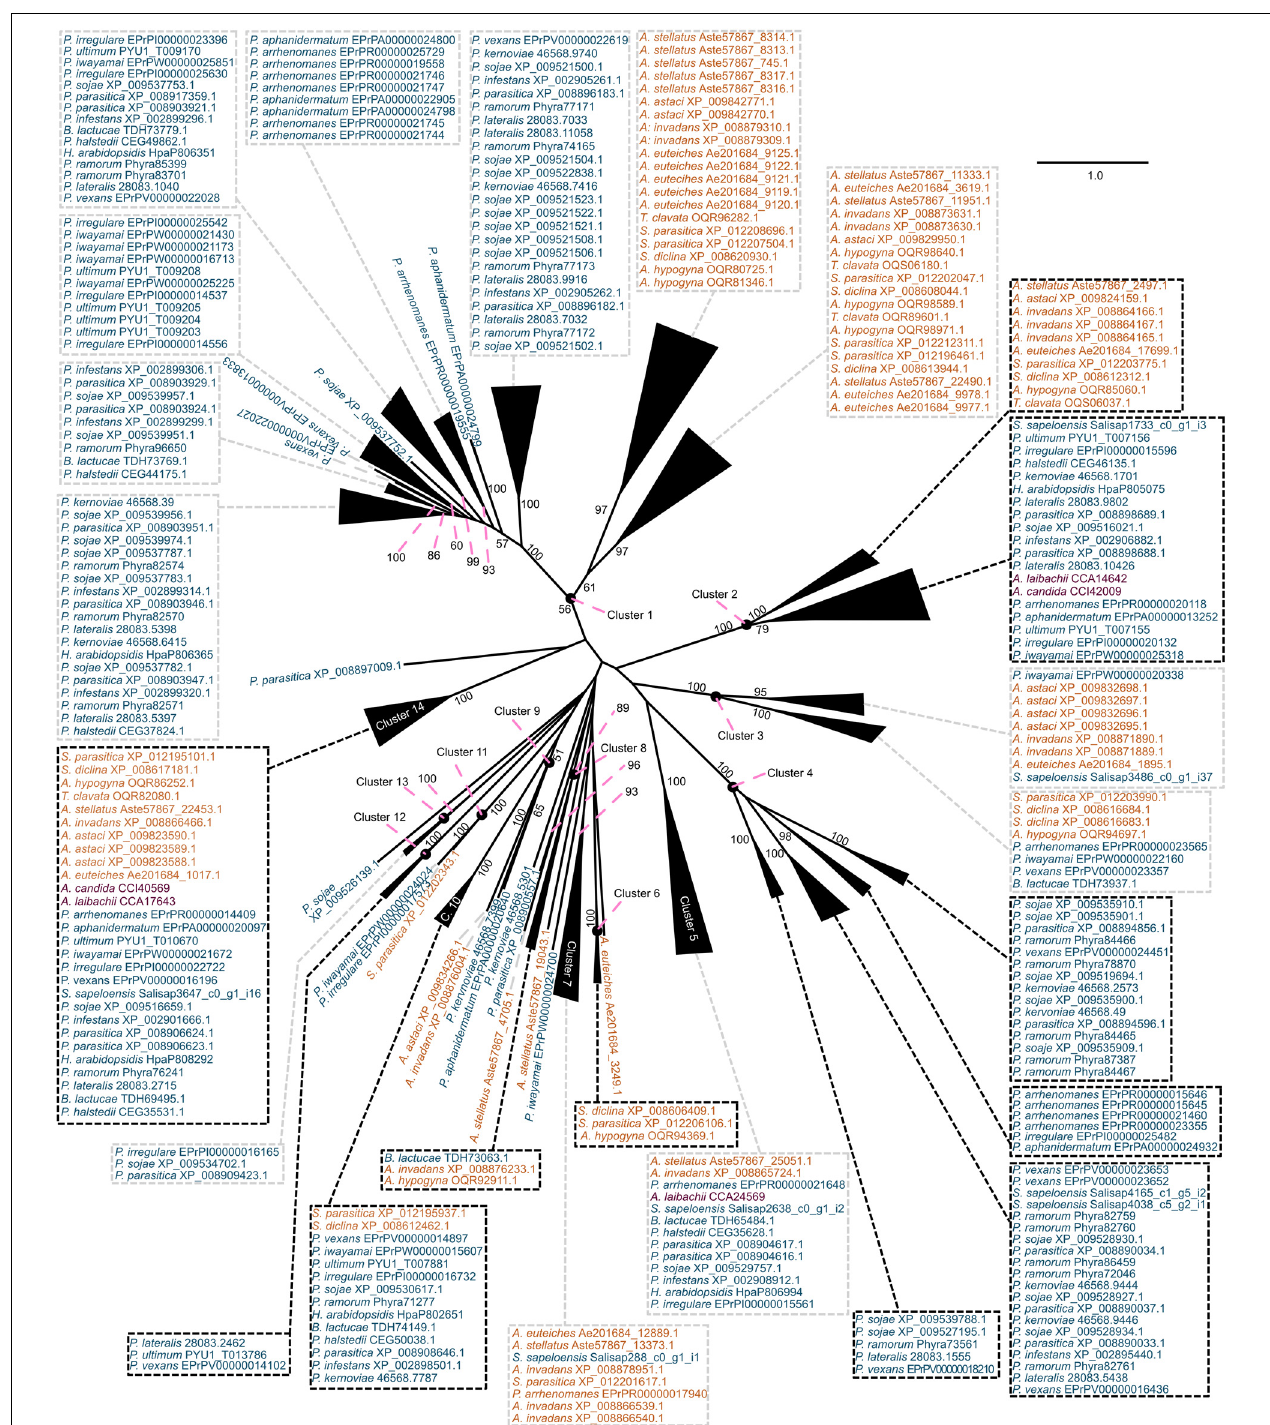
FIGURE 4 | Clustering of the carbohydrate esterase 10 (CE10) gene family in oomycetes utilizing a phylogenetic approach. A maximum likelihood phylogeny of 313 CE10 protein sequences mined from 25 oomycete genomes and the transcriptome of Salisapilia sapeloensis is shown. The tree was computed based on an L-INS-I alignment using IQ-TREE multicore version 1.5.5; ModelFinder was used to test 144 protein models, and WAG+I+G4 was chosen according to the Bayesian information criterion (BIC) as the best model. One hundred bootstrap replicates were computed. Only bootstrap values ≥ 50 are shown. Colors indicate the phylogenetic affiliation of the species: blue, Peronosporales; orange, Saprolegniales; purple, Albugonales. Classification into orders is based on McCarthy and Fitzpatrick (2017). Alignment is provided in Supplementary Dataset S4 .